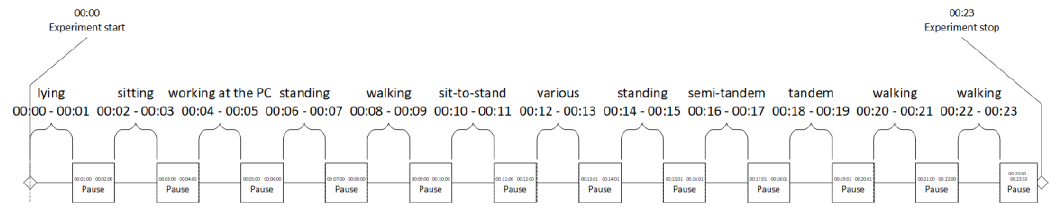
Figure 1. Task sequence and duration.